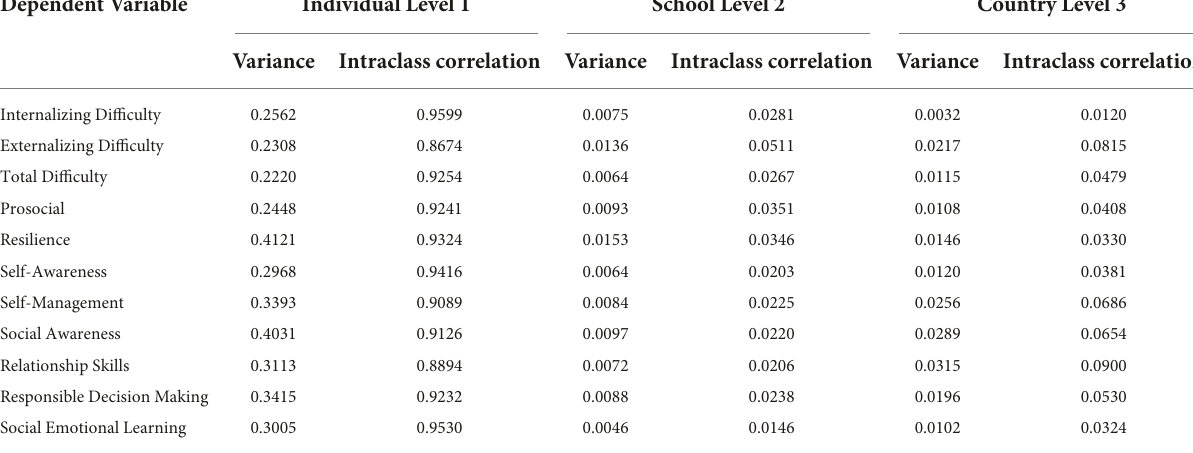
TABLE 9 Variances and Intraclass correlations at levels 1, 2 and 3 ( Adolescent Evaluations).